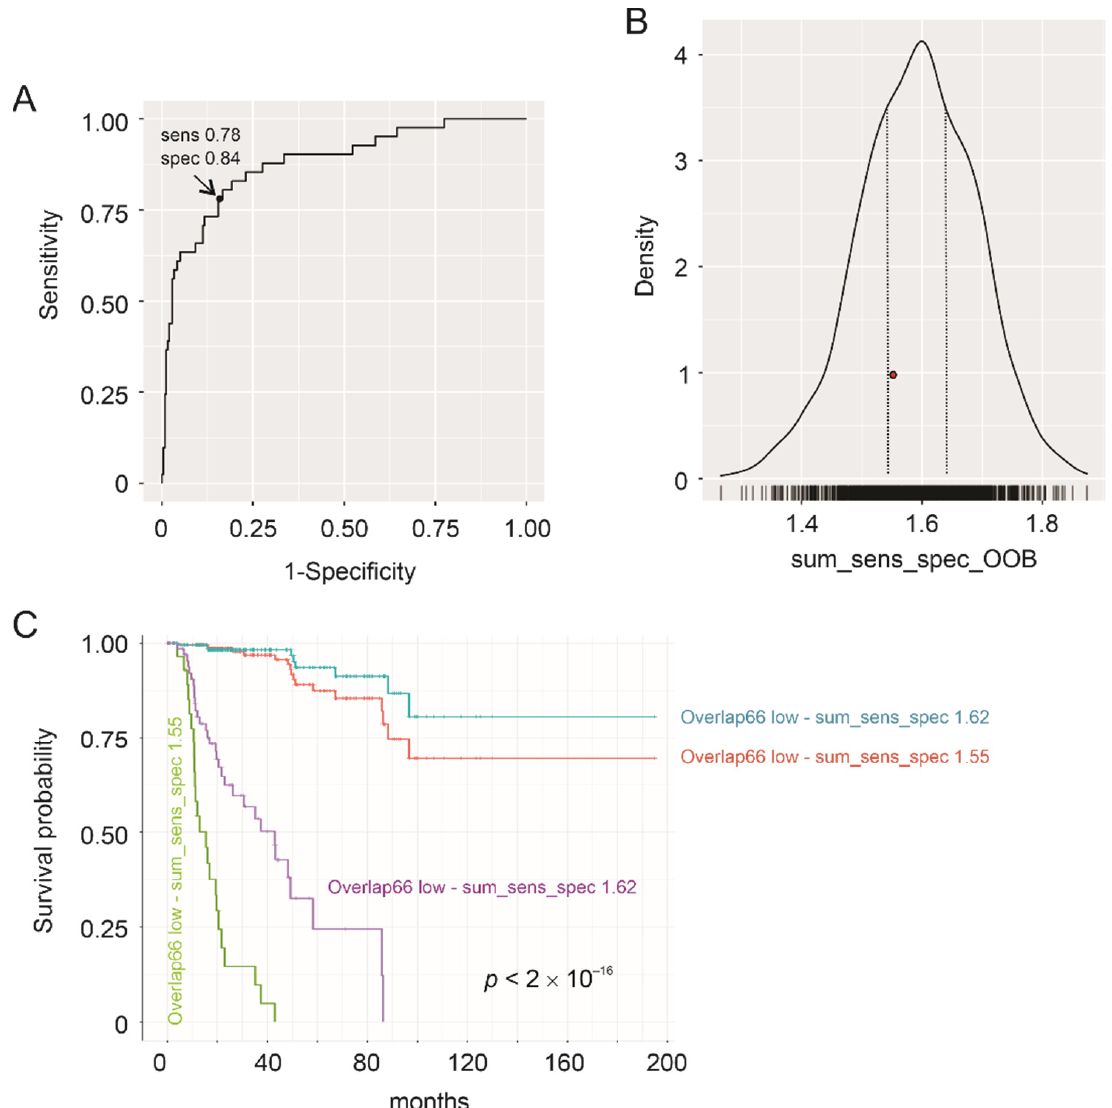
Figure 6. Validation of Overlap66 risk score in stratification of pRCC fatality risk. Cutoff points were estimated using Kernel smoothing method coupled with bootstrapping ( n = 1000). The average in-bag and out-of-bag (OOB) bootstrap samples are 63.2% and 36.8% of the full sample size respectively. The analysis was performed using the cutpointr R package (https://github.com/thie1e/cutpointr, accessed on 21 July 2021). ( A ) ROC curve with the optimal cutoff point indicated (arrow); sens: sensitivity, spec: specificity, and the sum_sens_spec: 1.62. ( B ) Distribution of out-of-bag (OOB) metric values. The most predictions occur in these OOB samples ( n = 1000) at the sum_sens_sepc value 1.6. The region marked by the 2 dotted lines includes a range of sum_sens_sepc values that frequently stratify the fatality risk with high accuracy. The red dot represents a sum_sens_sepc value 1.55. ( C ) Classification of pRCC tumors into a high- and low-risk group using two indicated cutpoints; the sum_sens_sepc 1.62 cutoff point was obtained using Kernel method and the sum_sens_sepc 1.55 cutoff point (see the red dot in panel ( B )) was derived using Maximally selected LogRank statistics (see Figure S9). The p value is for both